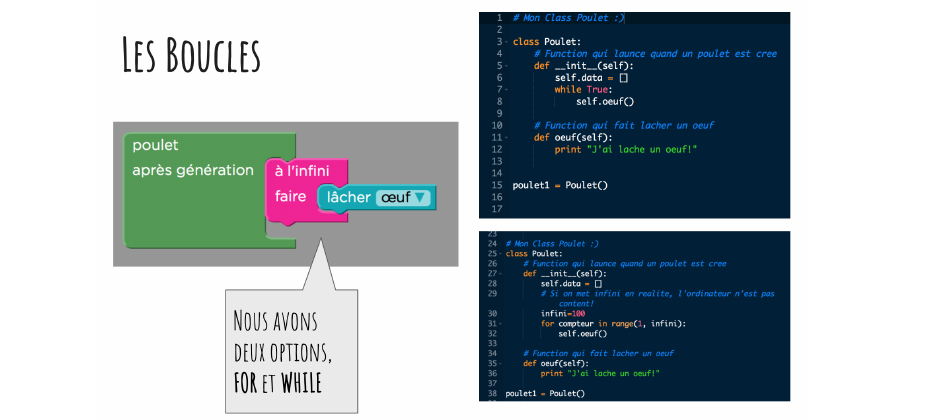
Figure 3. Loops explanation in